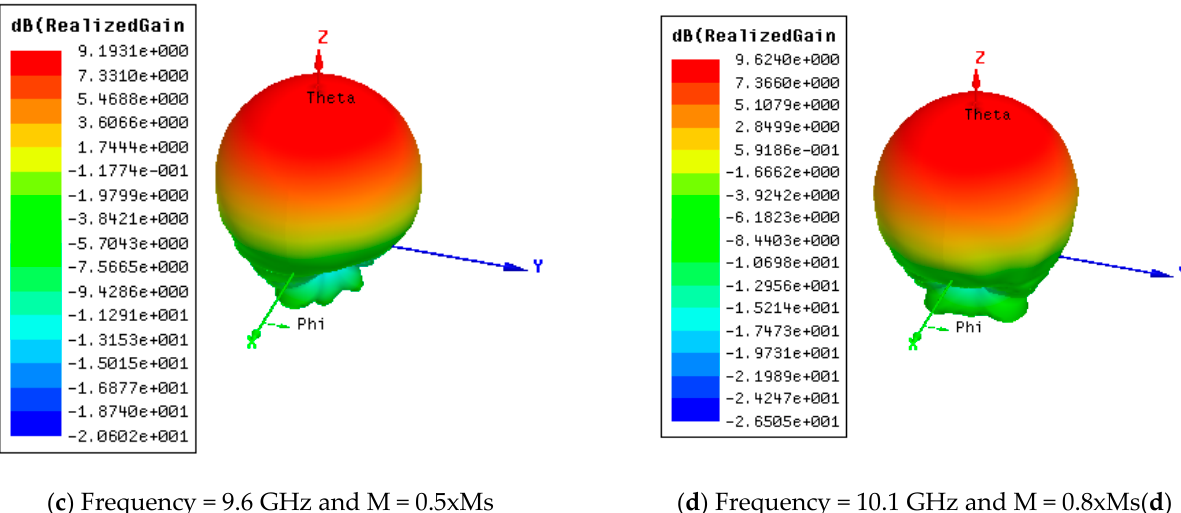
Figure 7. Radiation pattern and gain of antenna for various values of magnetized ferrite at the resonant frequency.